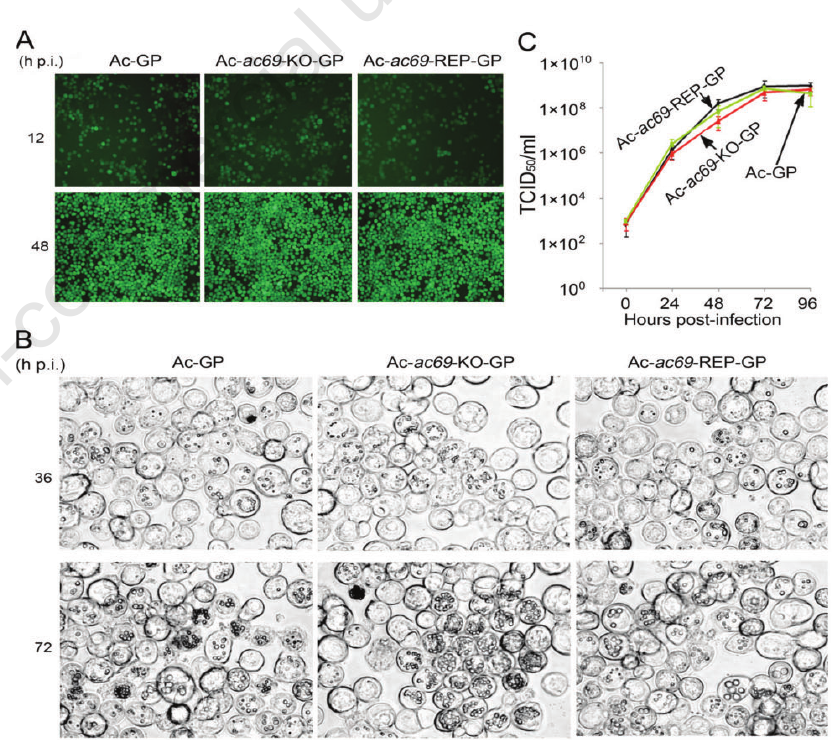
Figure 2. Analysis of viral replication in virus-infected Sf-9 cells. (A) Fluorescence microscopy of Ac-GP, Ac- ac69 -KO-GP or Ac- ac69 -REP-GP-infected Sf-9 cells at 12 and 48 h p.i. (B) Light microscopy of Ac-GP, Ac- ac69 -KO-GP or Ac- ac69 -REP-GP-infected Sf-9 cells at 36 and 72 h p.i. (C) Virus growth curve generated from Ac-GP, Ac- ac69 -KO- GP or Ac- ac69 -REP-GP-infected Sf-9 cells. Sf-9 cells were infected at an MOI of 5 from each virus. Cells culture supernatants were harvested at the selected time points and assayed for the production of infectious virus by TCID assay. Each datum point repre- 50 sents the average titer derived from three independent infections. Error bars represent standard